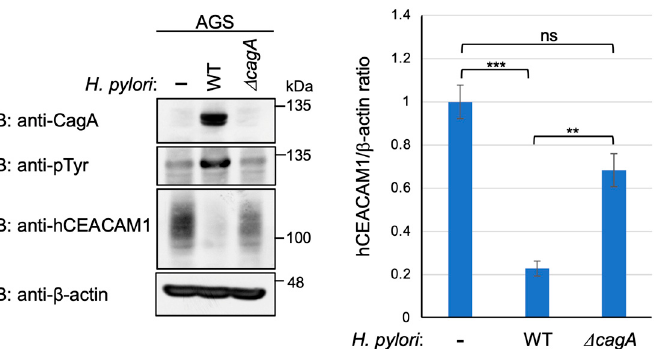
Figure 6. CEACAM-mediated CagA delivery reduces the level of cellular CEACAM protein. AGS cells were infected with wild-type (WT) H. pylori or isogenic Δ cagA strain for 7 h at a MOI of 100. The cells were harvested and analyzed for the expression of total CEACAM1 protein. Experiments were carried out in biological triplicates ( n = 3) and the representative images are shown ( left ). Quantification of the intensity of CEACAM1 relative to β -actin ( right ). Error bars indicate mean ± SD, n = 3. Data were analyzed by one-way ANOVA and the Bonferroni post hoc test. *** p < 0.001, ** p < 0.01, ns; non-significant.